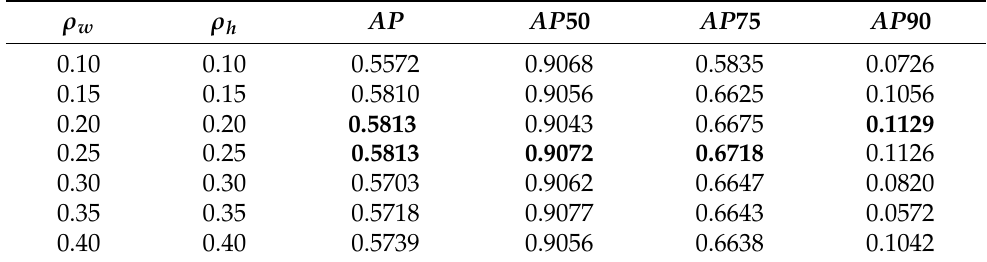
Table 2. Effect of Hyperparameters ρ w and ρ h .